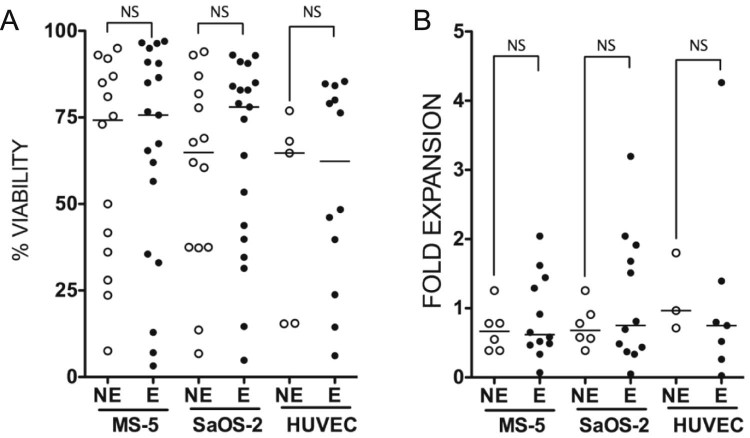
AML samples viability and proliferation in co-culture with MS-5 or SaOS-2 or HUVEC do not distinguish E and NE. (A) Data shown represents the NE and E AML cells percent viability after 1-week co-culture with MS-5, SaOS-2 or HUVEC assessed by DAPI and Annexin V exclusion (NE, E on MS-5 n = 14, 19. NE, E on SaOS-2 n = 14, 19. NE, E on HUVEC n = 5, 12). (B) Data shown represents AML fold expansion determined by FACS (NE, E on MS-5 n = 14, 19. NE, E on SaOS-2 n = 14, 19. NE, E on HUVEC n = 5, 12). Each symbol represents a single patient sample cultured in triplicate wells. Comparisons were made using a paired Student's t-test.